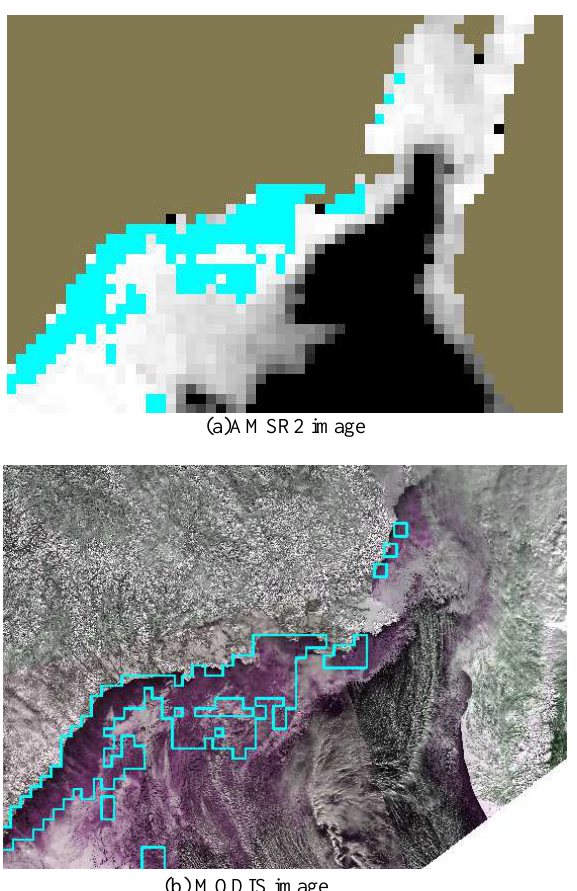
Figure 9. Thin ice area extraction result (Cyan: extracted area) (Sea of Okhotsk, February 26,